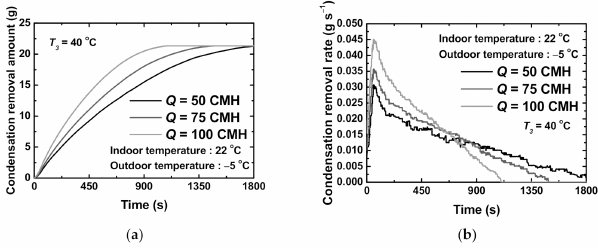
Figure 8. Result of Case 3 at various purge air flow rates: ( a ) condensation removal quantity; ( b ) condensation removal rate over